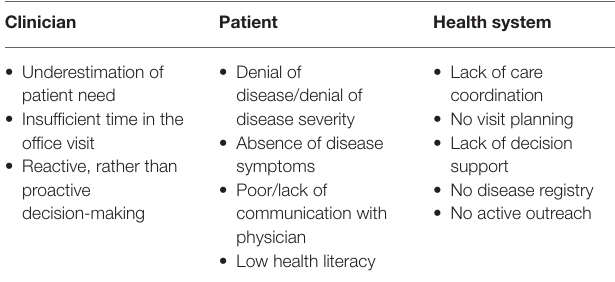
TABLE 6 | Reasons underlying therapeutic inertia in the management of